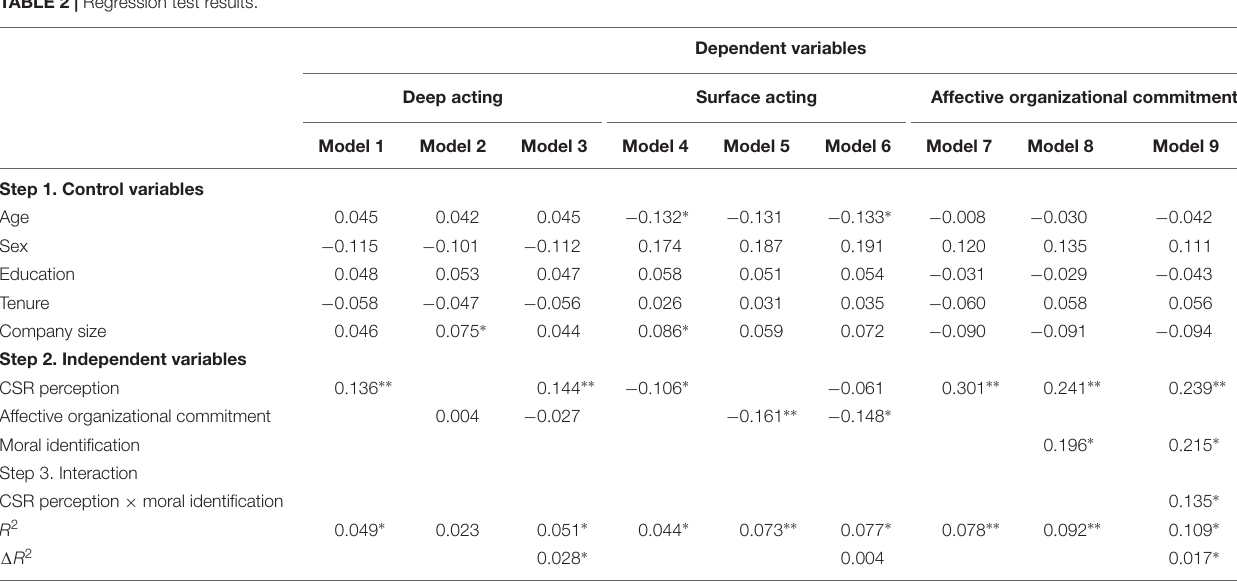
TABLE 2 | Regression test